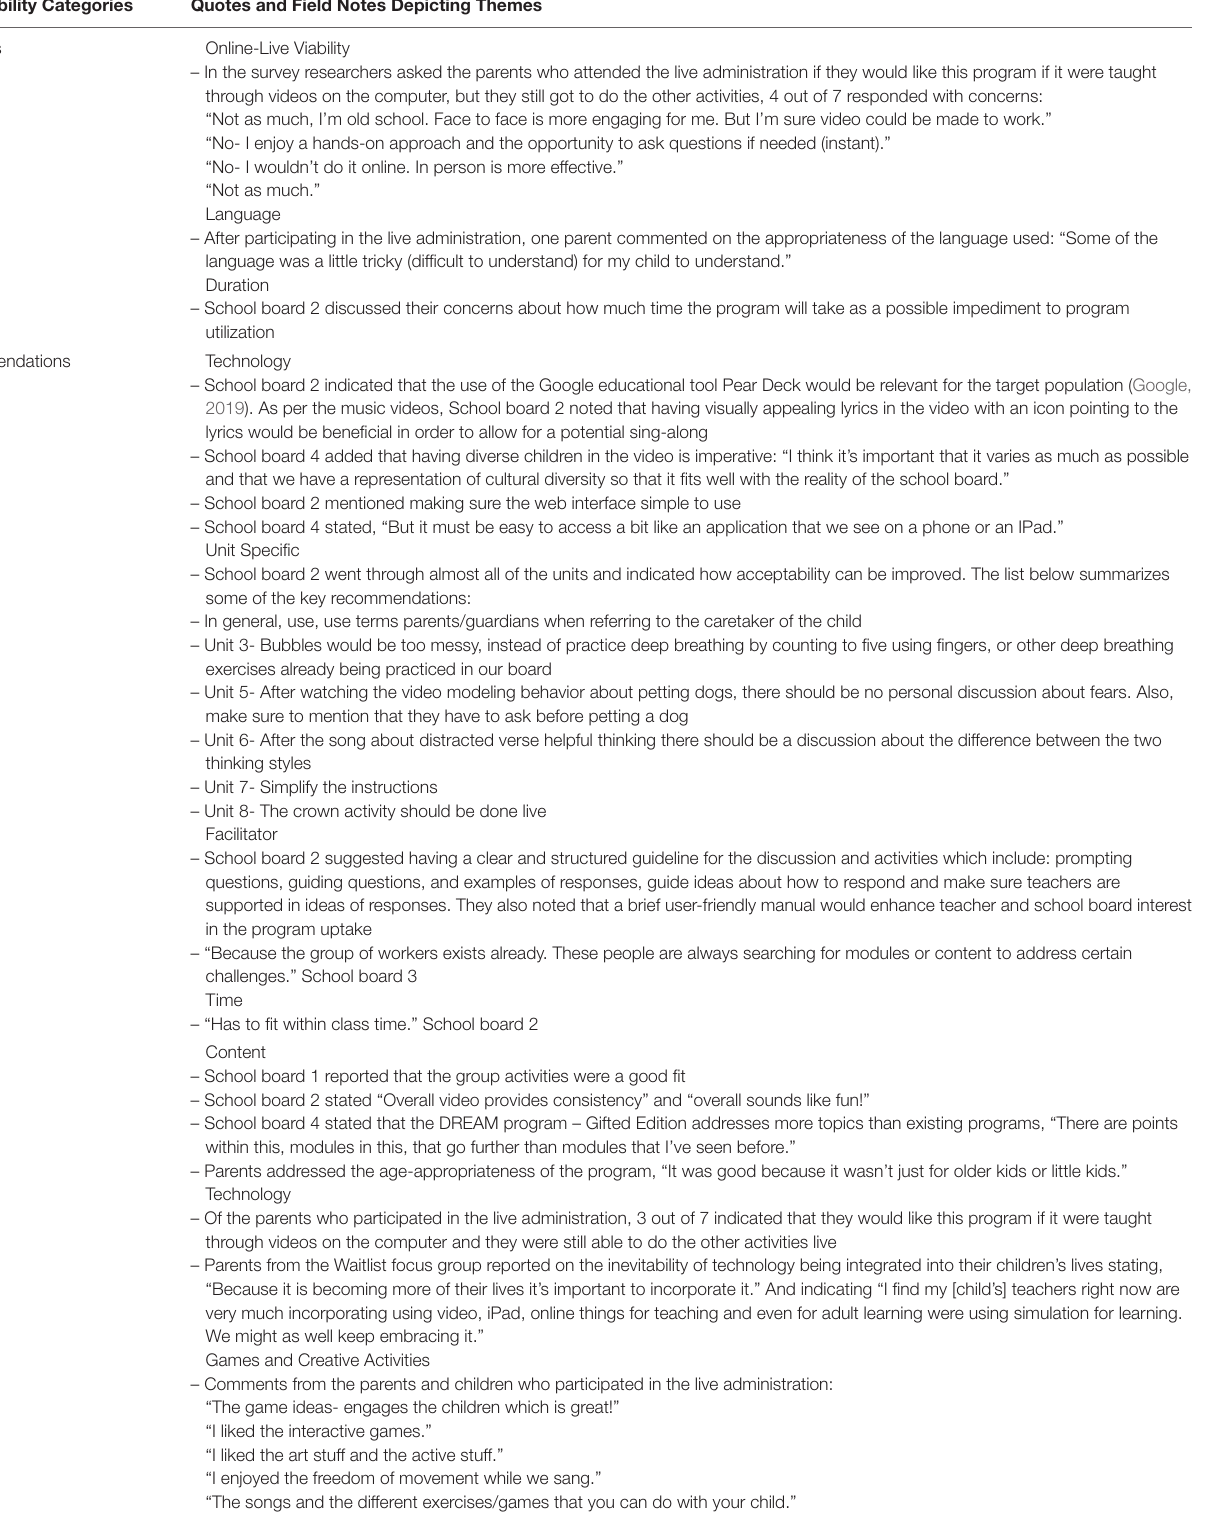
TABLE 6 | Sustainability qualitative